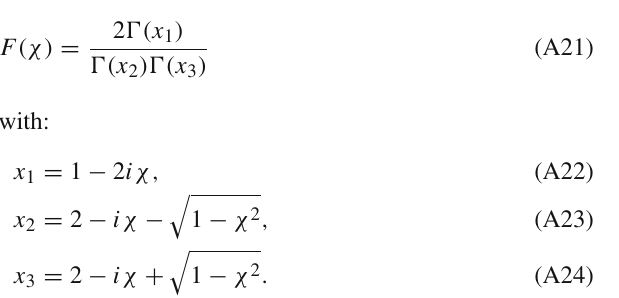
Fig. 3 Twopossibleapproximationsforthefunction χ 2 | F (χ) | 2 (black line)mentionedinthetext.Option(i)correspondsto f (χ) = g (χ) (blue line) and option (ii) corresponds to f (χ) = h (χ) (red line). We observe that χ 2 h (χ) is a better approximation to the exact solution in the full